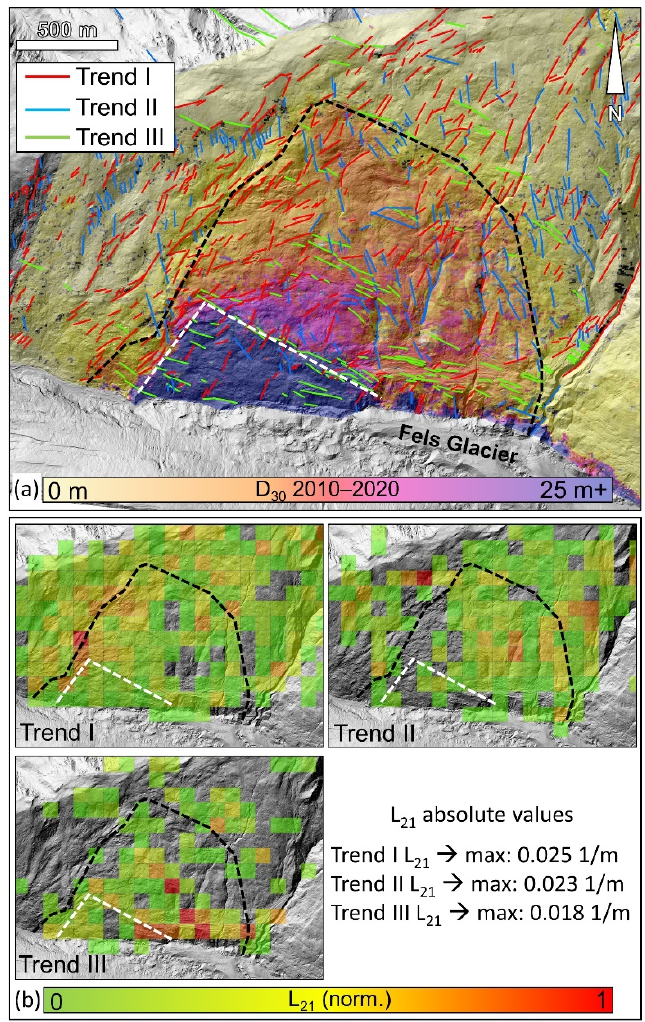
Figure 9. Comparison of lineament distribution and intensity and displacement magnitudes com- puted using ST. Black and white dashed lines outline the landslide area and the fast-moving toe, respectively. ( a ) Lineaments identified on the ALS map, distinguished by trend and superimposed on the total 2010–2020 cumulative displacement magnitude map. ( b ) Normalized lineament intensity cell maps created for each of the identified lineament trends. Note the higher L 21 for trend I along the western boundary of the landslide, for trend II along the upper and eastern boundary, and for trend III in the lower slope. A local increase in L 21 for trend III is observed in the upper slope, near the landslide